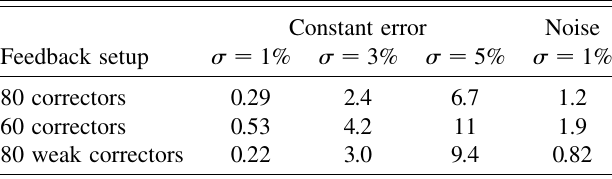
TABLE III. Additional emittance growth for imperfect com- pared to ideal correctors. The constant error can be thought of as a corrector strength calibration error which is the same from pulse to pulse. The noise is a corrector strength error varying independently from one pulse to the other. The emittance is stated in [ 10 (cid:1) 3 nm